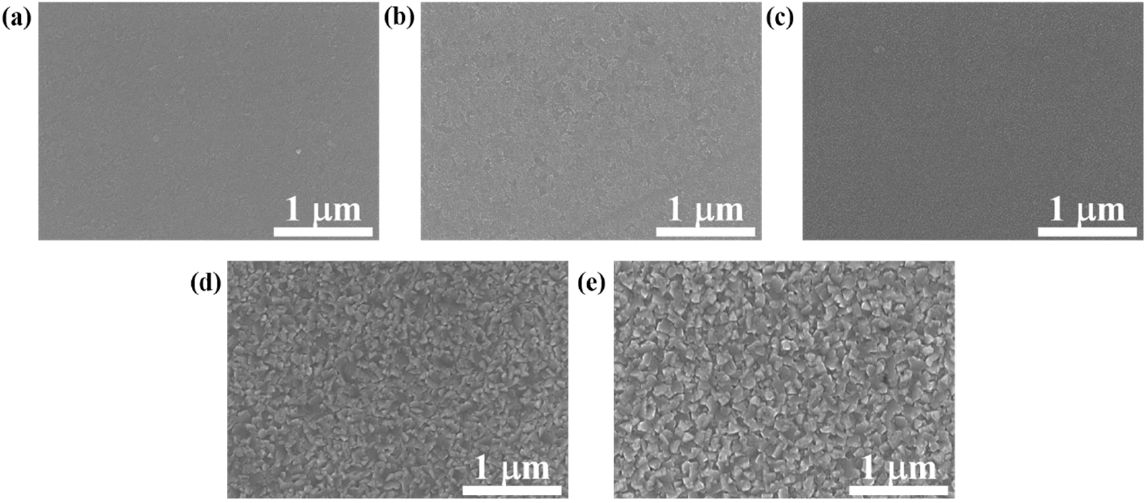
Figure 8. Surface morphologies of FeCo thin films with thickness of 50 nm deposited at ( a ) 25 °C, ( b ) 200 °C, ( c ) 400 °C, ( d ) 475 °C and ( e ) 550 °C.